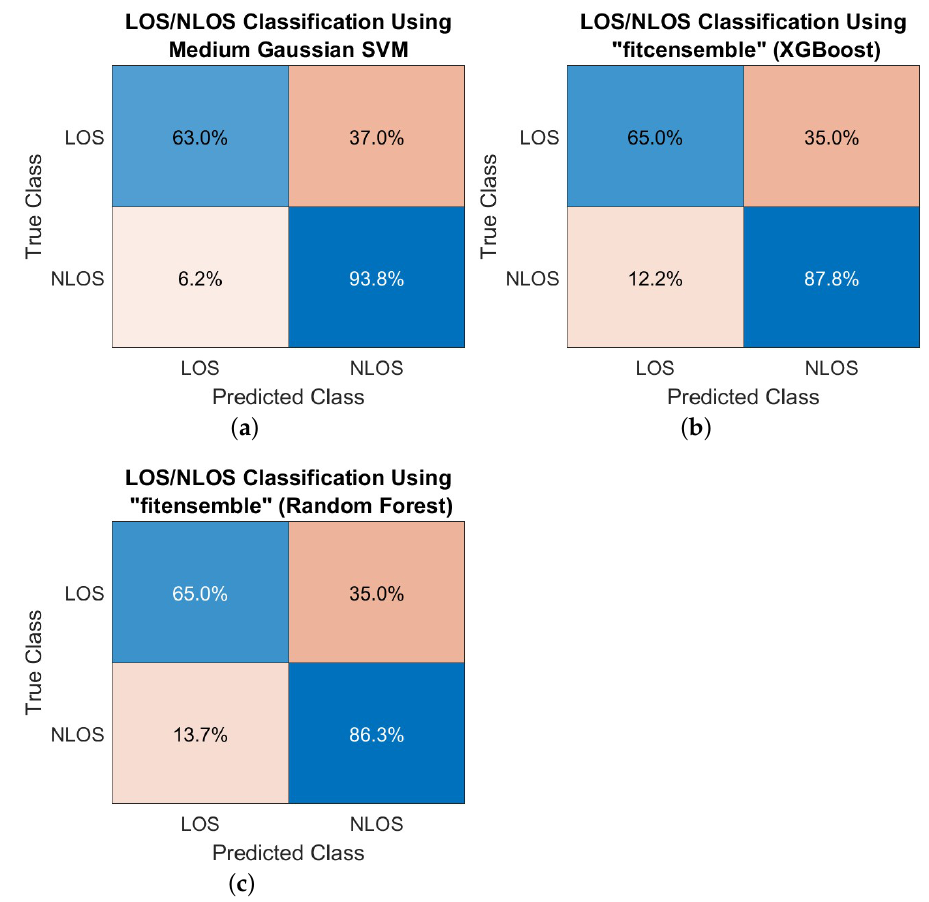
Figure 6. Examples of confusion matrices for ( a ) medium Gaussian SVM, ( b ) XGBoost and ( c ) Random Forest methods.